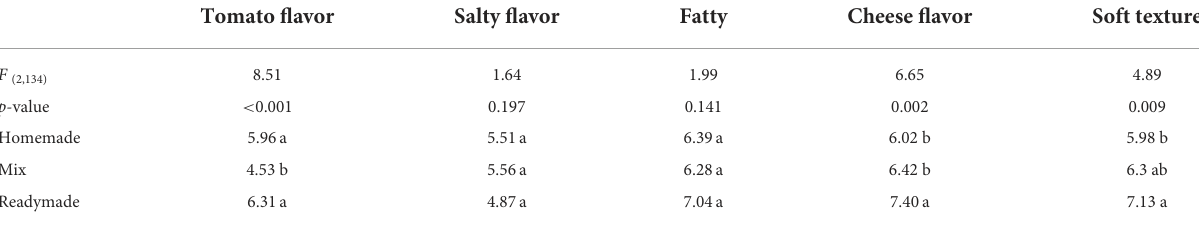
TABLE 3 Analyses of variance of the sensory attributes of the different types of pizza